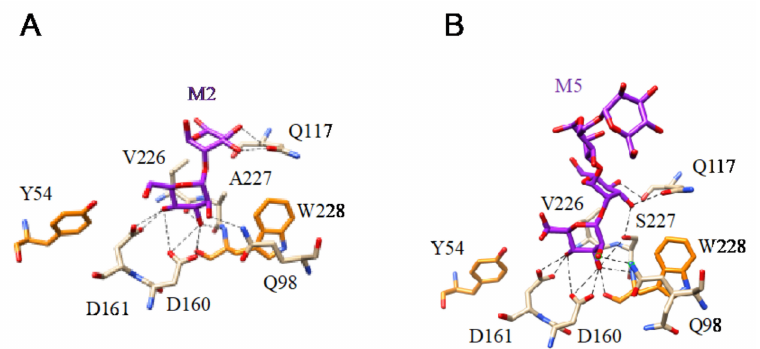
Figure 14. ( A ). Network of hydrogen bonds (black dashed lines) anchoring Mannobiose (M2) to the amino acid residues forming the CBS of flocculin Flo5 from Saccharomyces cerevisiae (PDB code 2XJU). Aromatic residue Y54 and FW228 participating in stacking interactions with the pyranose ring of the first Man residue are colored orange. ( B ). Network of hydrogen bonds (black dashed lines) anchoring Mannopentaose (M5) to the amino acid residues forming the CBS of flocculin Flo5 from Saccharomyces cerevisiae (PDB code 2XJT). Aromatic residue Y54 and W228 involved in stacking interactions with the pyranose ring of the first Man of the oligomannoside are colored orange. In the glycan array analyses performed at Consortium for Functional Glycomics for TbCVN, the Tuber borchii Man-specific lectin yielded the best results with the following glycans arranged in decreasing order of affinity (Figure 15):